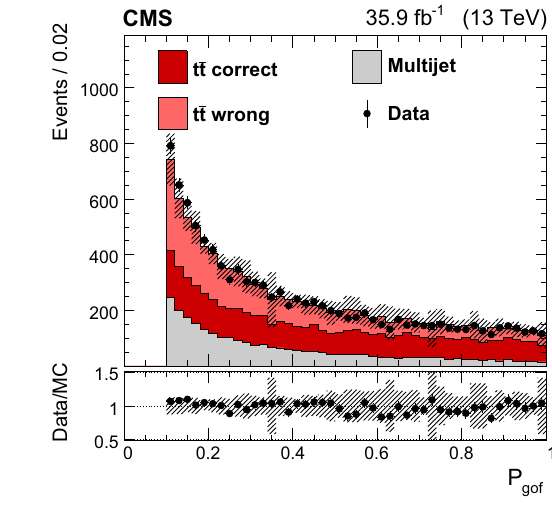
Fig. 1 The Δ R ( bb ) (left) and P gof (right) distributions of data com- paredtosimulatedsignalandthemultijetbackgroundestimate.Foreach event, the parton-jet assignment yielding the smallest χ 2 in the kine- matic fit is used. The simulated signal events are classified as correct or wrong assignments and displayed separately, and the distributions